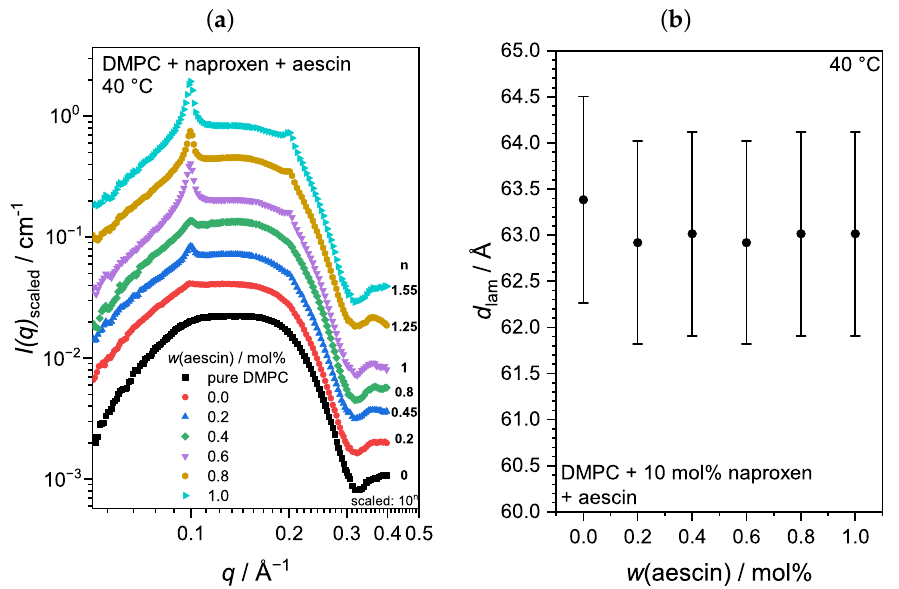
Figure 9. ( a ) SAXS curves of DMPC vesicles with 10mol% naproxen and varying amounts of aescin at T = 40 °C. Scattering curves are scaled by powers of 10 for better visibility. ( b ) Lamellar repeat distance d lam of the correlated bilayers calculated from the maximum of the first order Bragg peak at T = 40